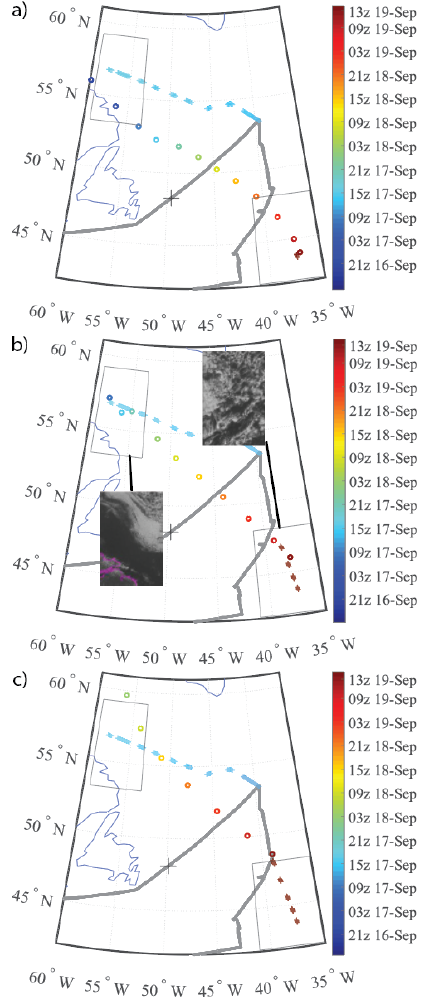
Figure 7. The location of FLEXPART back trajectories averaged over 6h intervals (shown as open circles) and low-level ( ∼ 0 . 1km) C130 surface measurements (shown as colored lines) are both col- ored as a function of time. The color bar range shifts by 40min in each panel and is defined by the start and end of a 3d FLEX- PART back trajectory initiated at the C130 horizontal location at 500m above the sea surface. The initialization times for the back trajectories are (a) 14:24UTC on 19 September, (b) 15:04UTC on 19 September, and (c) 15:44UTC on 19 September. The gray line represents the R/V Atlantis ship track, and the black cross on the ship track in panels (a) – (c) represents the location of the R/V At- lantis for the initialized back trajectory. The black 5 ◦ × 5 ◦ boxed area that overlaps the trajectory (b) and FLT17 surface measure- ments identifies the C130 measurements used for comparison with downwind C130 measurements from FLT19 shown by the second 5 ◦ × 5 ◦ area. GOES-East visible images are shown in panel (b) for both 5 ◦ × 5 ◦ areas corresponding to the back trajectory initialization time and the 48h back trajectory interval that overlaps with FLT17 near-surface measurements. Table 3 contains comparisons between measurements made on FLT19 and measurements from the closed- cell and cloud-free region upwind from